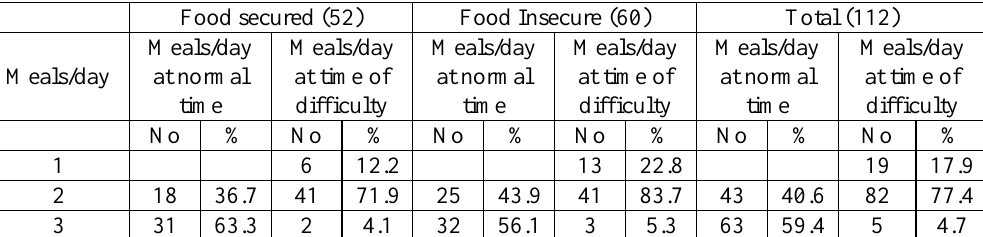
Table 8. Number of meals per day for children between the age of 6 and17 at normal time and time of